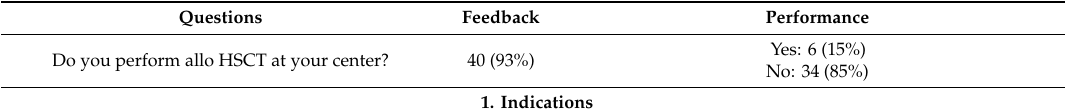
Table 7. Allogeneic hematopoietic stem cell transplantation ( n =